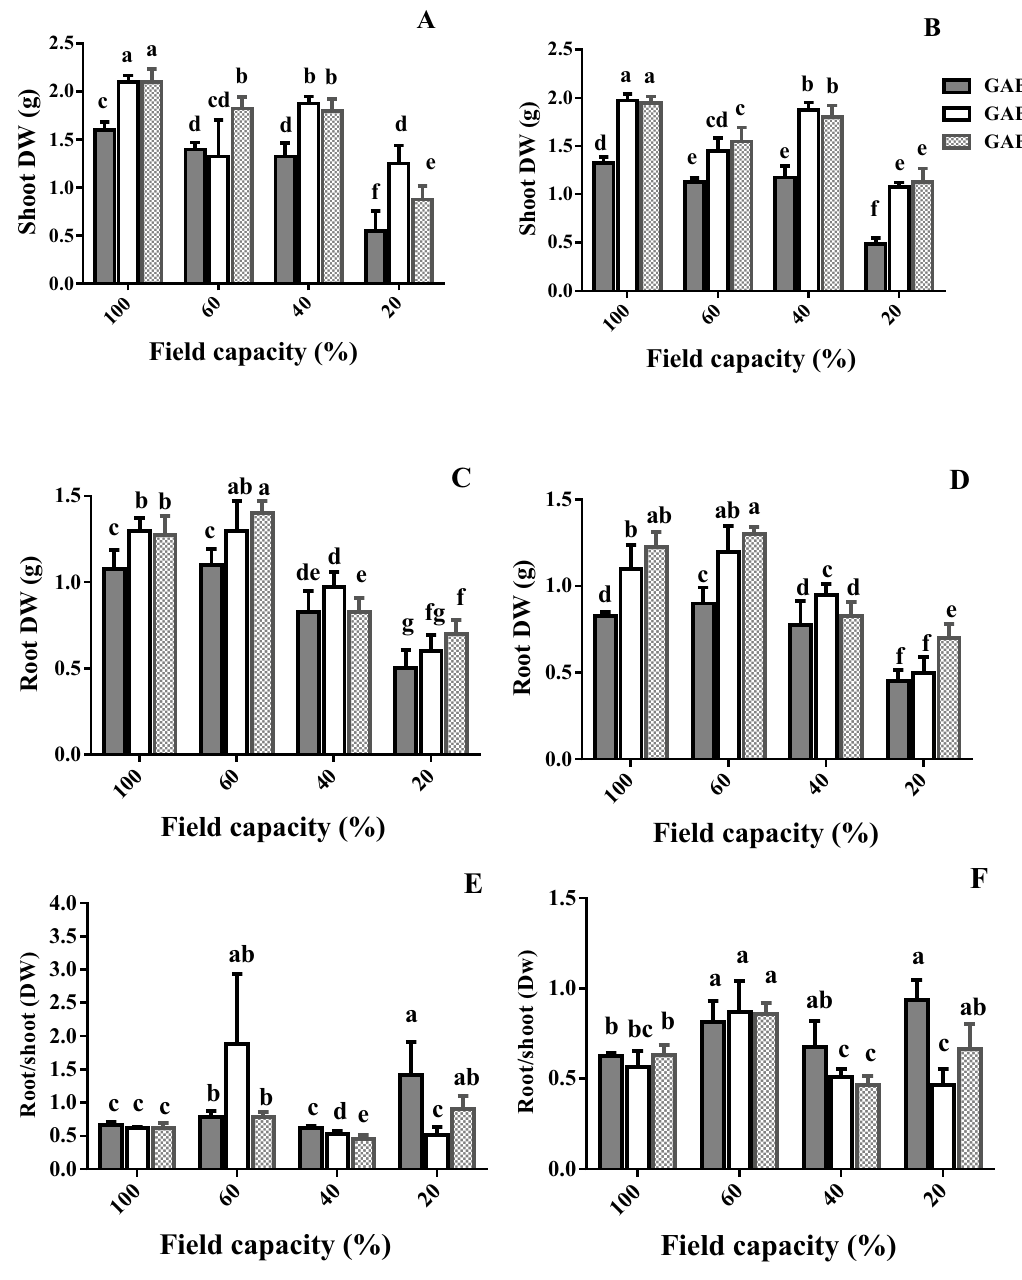
Figure 1. Shoot dry weight (DW; A , B ), root DW ( C , D ), and root-to-shoot ratio ( E , F ) of cv. Arman (tolerant; left panels) and cv. Azad (sensitive; right panels) chickpea plants receiving exogenous application of γ-aminobutyric acid (GABA) at different concentrations (0, 25 and 50 μM) under different watering levels (100, 60, 40 and 20% field capacity) during cultivation. The difference in the y-axis scale of root-to-shoot ratio (Fig. 1E,F) panels ought to be noted. Within each insert, different letters indicate significant differences. Error bars indicate SEM (n =